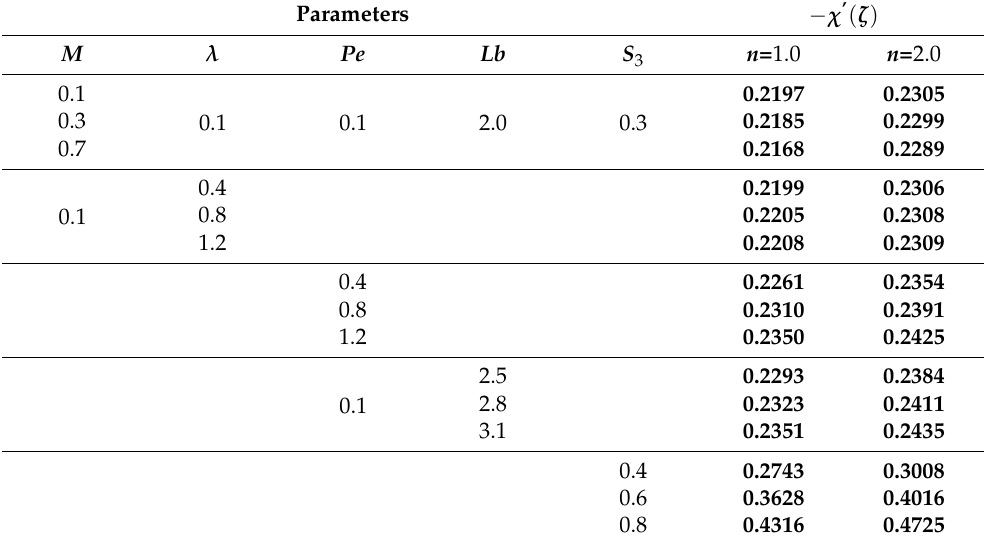
Table 5. Effect of flow factor over local density number of microorganisms − χ (cid:48) ( ζ ) at ζ = 0.